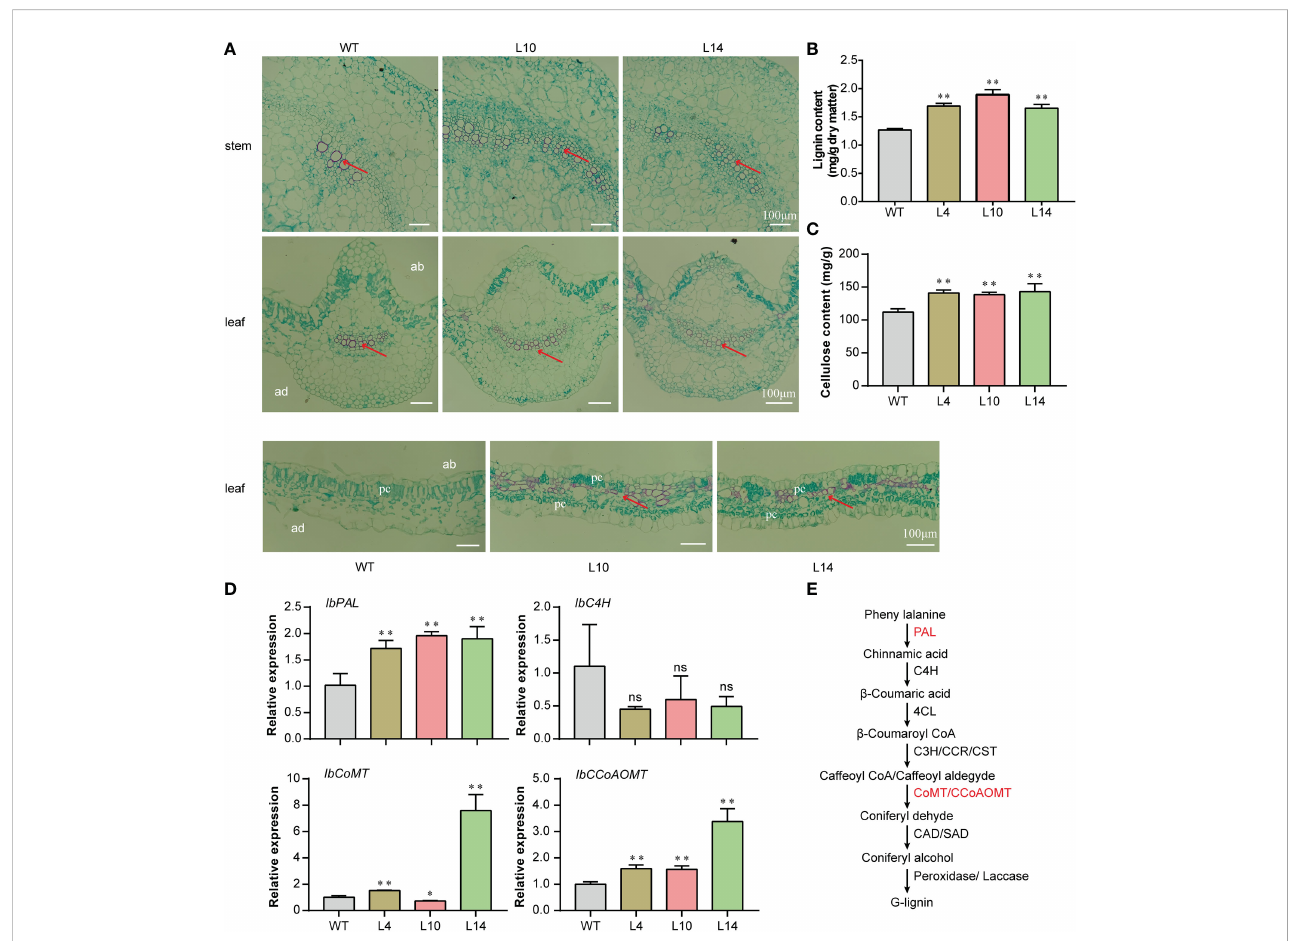
FIGURE 9 Histological observation of the IbNAC43 -overexpressed and wild-type (WT) plants. (A) Paraf fi n sections. ad , adaxial side; ab , abaxial side; pc , palisade cells. Scale bar , 100 m m. (B) Lignin content. Data are presented as the mean ± SE ( n = 3). (C) Mean cellulose content from IbNAC43 -overexpressed and non-overexpressed sweet potato plants. Data are presented as the mean ± SE ( n = 3). (D) Expression levels of the lignin biosynthesis-related genes. (E) Biosynthesis pathway of lignin. PAL , phenylalanine ammonia-lyase; C4H , cinnamate-4-hydroxylase; 4CL , 4-coumarate-CoA ligase; C3H , p -coumaroyl-CoA3-hydroxylase; CoMT , caffeicacid-5- O -methyltransfenase; CCoAOMT , caffeoyl-CoA 5- O -methyltransfenase; CAD , cinnamyl alcohol dehydrogenase. Asterisks indicate signi fi cant differences compared to the WT based on a Student ’ s t -test. ** p < 0.01. ns, not signi fi